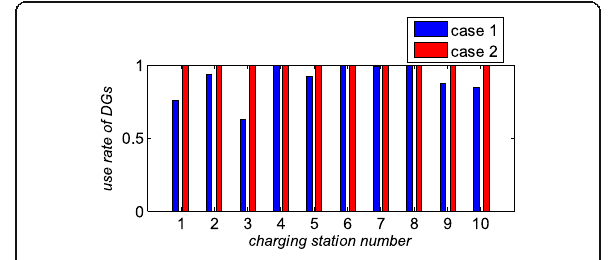
Fig. 7 DG utilization efficiency (fast charging)